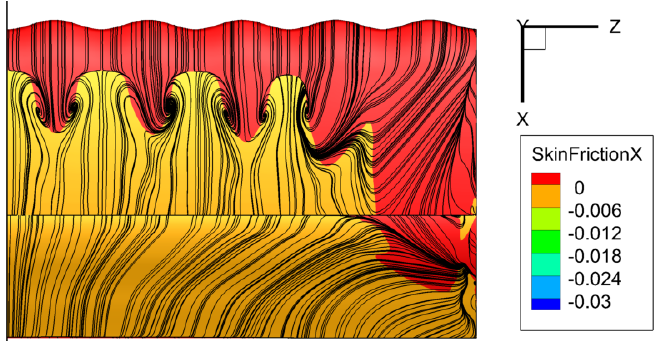
Figure 14. Relation between the shear stress lines and the separated flow over the front wing for the ME Tubercles (5 tubercles/2 A = 0.05 c ) geometry.